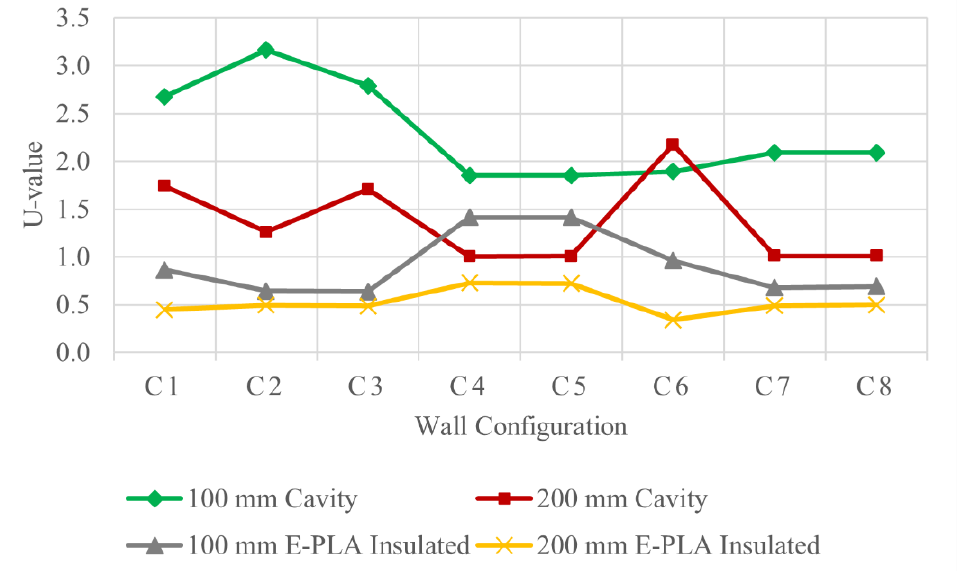
Figure 9. The U-value results obtained for 100 mm and 200 mm wall configurations with and without cavity insulation. Wall configurations with double-row triangular arrangements did not attain a no- ticeable reduction in U -values with the integration of E-PLA insulation. Observed reduc- tions in U -values were nearly 23% and 28% for 100 mm and 200 mm wall panels, respec- tively. However, all the other wall configurations attained a significant improvement in energy performance with E-PLA insulation. The measured reduction in U -values for the single-row triangular, lattice, and sinusoid wall arrangements with insulation ranged